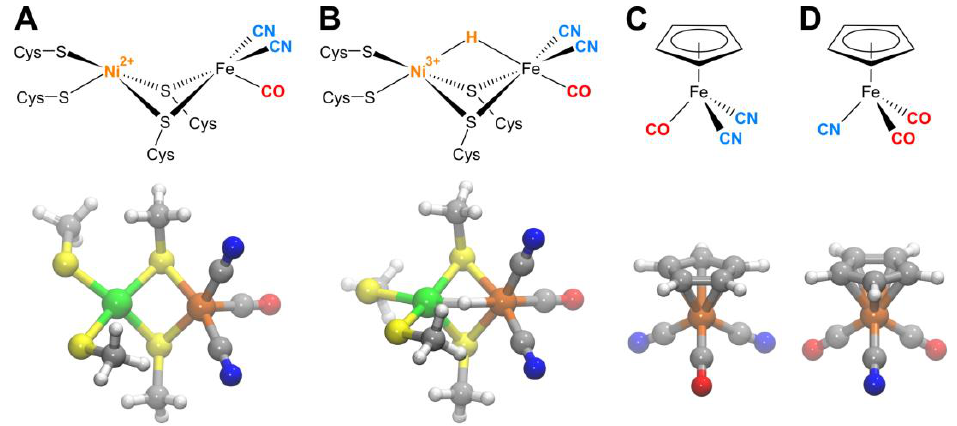
Figure 1. Schematic representation ( top ) and optimized geometries ( bottom ) of the molecular species studied. ( A ) Ni a − S state of [NiFe] hydrogenase. ( B ) Ni a − C state of [NiFe] hydrogenase. ( C ) Model complex 1 . ( D ) Model complex 2 . Net charges are not indicated. For details, see text